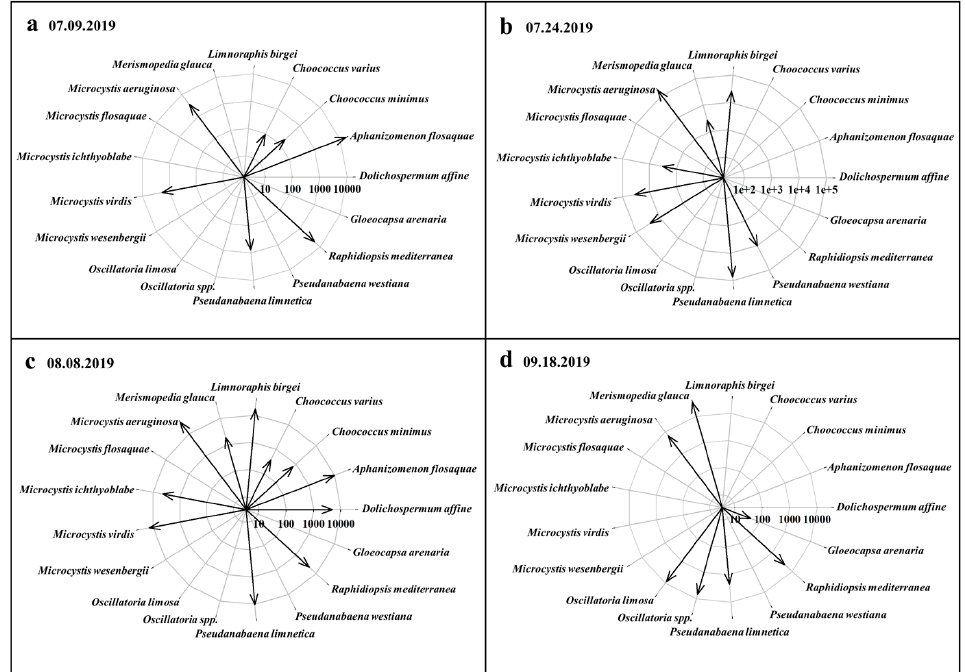
Figure 9. Radar plot of cyanobacteria cell composition with backscattering coefficient values at 550 nm for 2019—( a ) is the cell composition on 9 July; ( b ) is the composition on 24 July 24; ( c ) is the composition on 8 August; and ( d ) is the composition on 18 September. The black arrow indicates the concentration of cyanobacteria genus cells; the unit of concentration is cells mL − 1 .